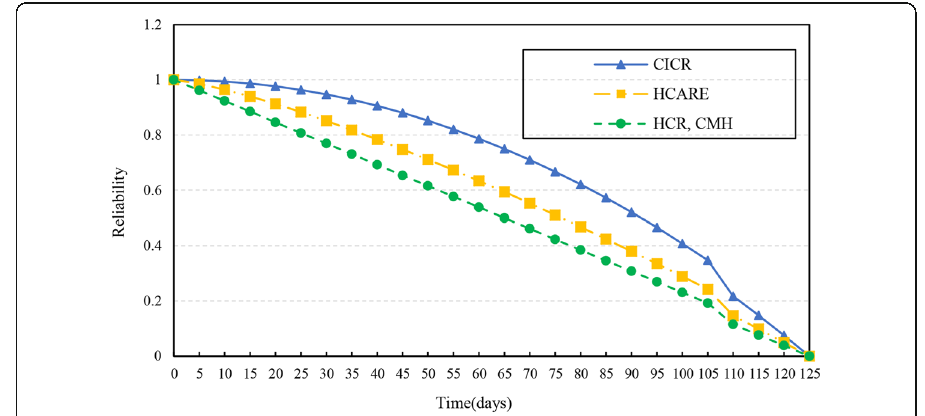
Fig. 12 Reliability of the region versus